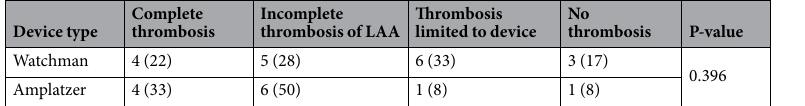
Table 3. Level of LAA thrombosis depending on device type. Values are total numbers (percentage). Analysis of contingency tables by Fishers’s exact test p-value = 0.396 revealed no significant